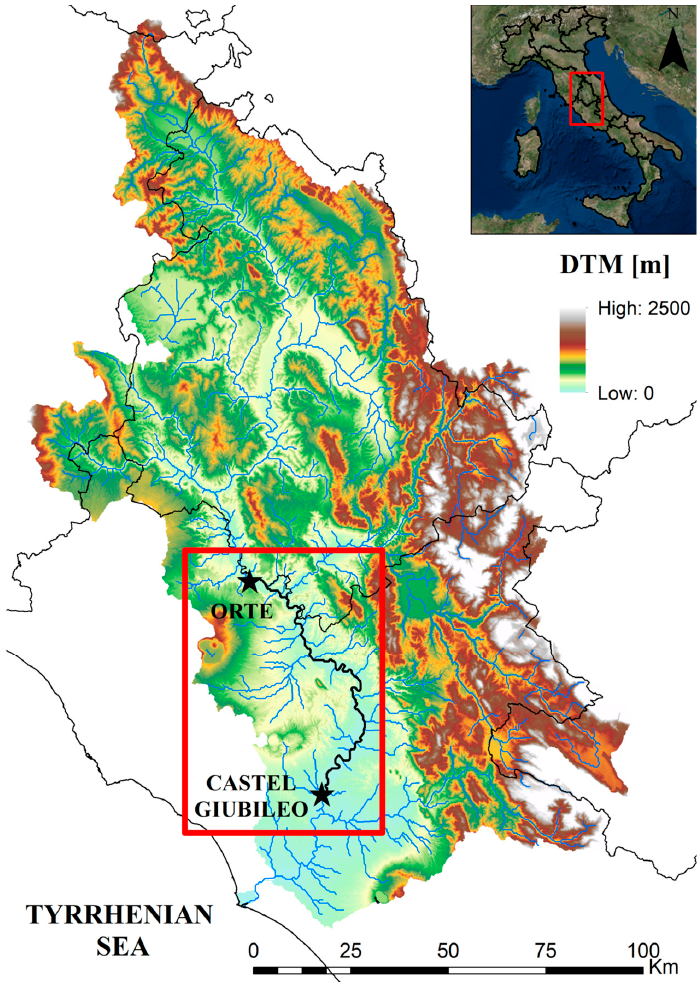
Figure 1. Map of the study basin of the Tiber River in central Italy.